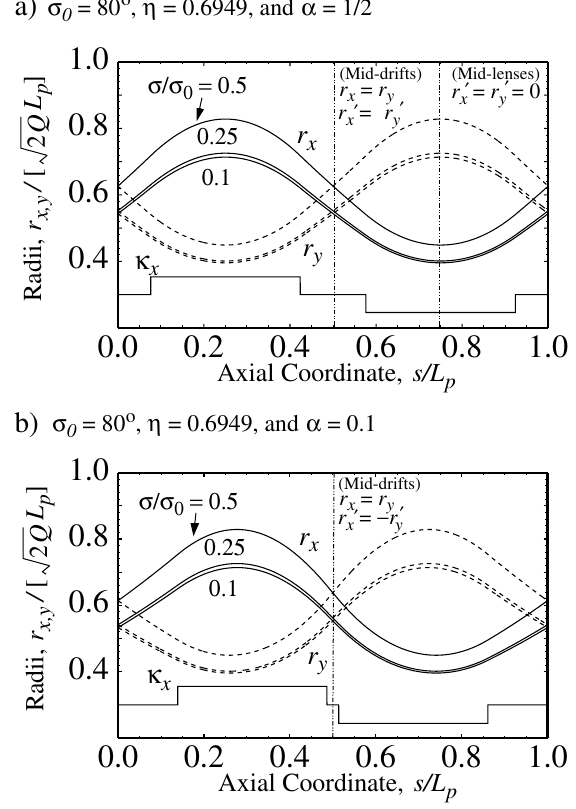
p (cid:4) versus = (cid:3) (cid:1)(cid:1)(cid:1)(cid:1)(cid:1)(cid:1)(cid:1) 2 Q L FIG. 15. Scaled matched beam envelope r j p for one period of a hard- normalized axial coordinate s=L p edge quadrupole focusing channel in Fig. 2(c). Solutions are (cid:1) 80 (cid:31) , (cid:31) (cid:1) 0 : 6949 , and values of (cid:24)=(cid:24) indi- shown for (cid:24) 0 0 cated for syncopation factors # (cid:1) 1 = 2 (FODO) and # (cid:1) 0 : 1 in (a) and (b), solutions are parametrized by L , (cid:24) , (cid:24)=(cid:24) , (cid:31) , and # . p 0 0 Numerical solutions are plotted for one lattice period in p (cid:4) ] = (cid:3) (cid:1)(cid:1)(cid:1)(cid:1)(cid:1)(cid:1)(cid:1) 2 Q L Fig. 15 in terms of scaled envelope radii [ r j p versus normalized axial coordinate ( s=L ) for # (cid:1) 1 = 2 p [FODO channel, (a)] and # (cid:1) 0 : 1 [strong syncopation, (b)]. In these plots, the undepressed single-particle phase advance (cid:24) is fixed, and the solution is shown for values 0 of (cid:24)=(cid:24) . Approximate, analytical solutions can also be 0 [25]. Symmetry points are indicated on the plot.